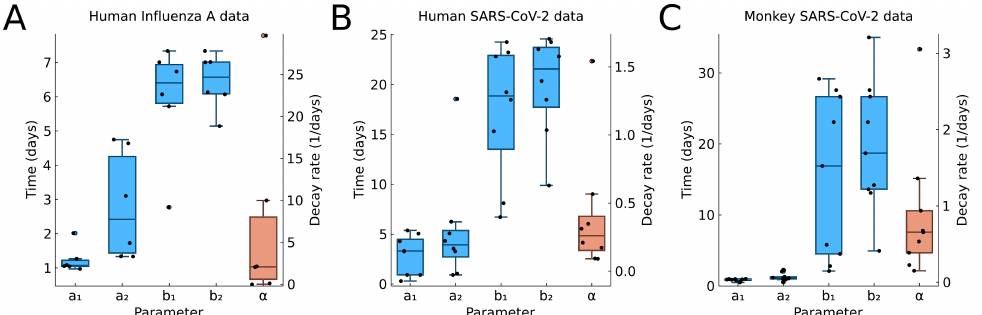
Figure 9. Boxplots for the estimated parameters using ( A ) human influenza A data, ( B ) human SARS-CoV-2 data from oropharynx saliva samples, and ( C ) macaque monkey SARS-CoV-2 data. Time-related parameters are shown in the blue boxplot, and the decay rate is shown in the red boxplot with a separate axis on the right. Points indicate the individual best estimate shown in Figures 6–8, and in Table